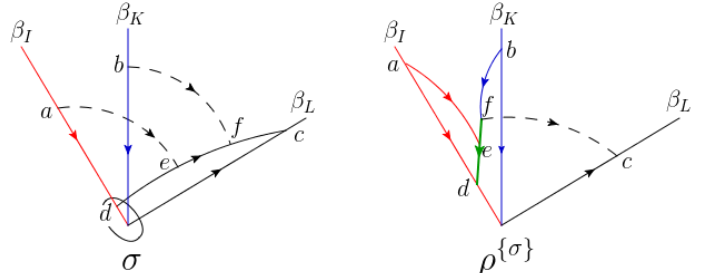
Figure 10. The example where two jet subgraphs have a nontrivial overlap. In (cid:26) f (cid:27) g , the red propagators are parallel to (cid:12) (cid:22) ; the blue propagators are parallel to (cid:12) (cid:22) I (cid:22) parallel to (cid:12) . The fact that these propagators are (cid:12)xed to certain directions has been explained L